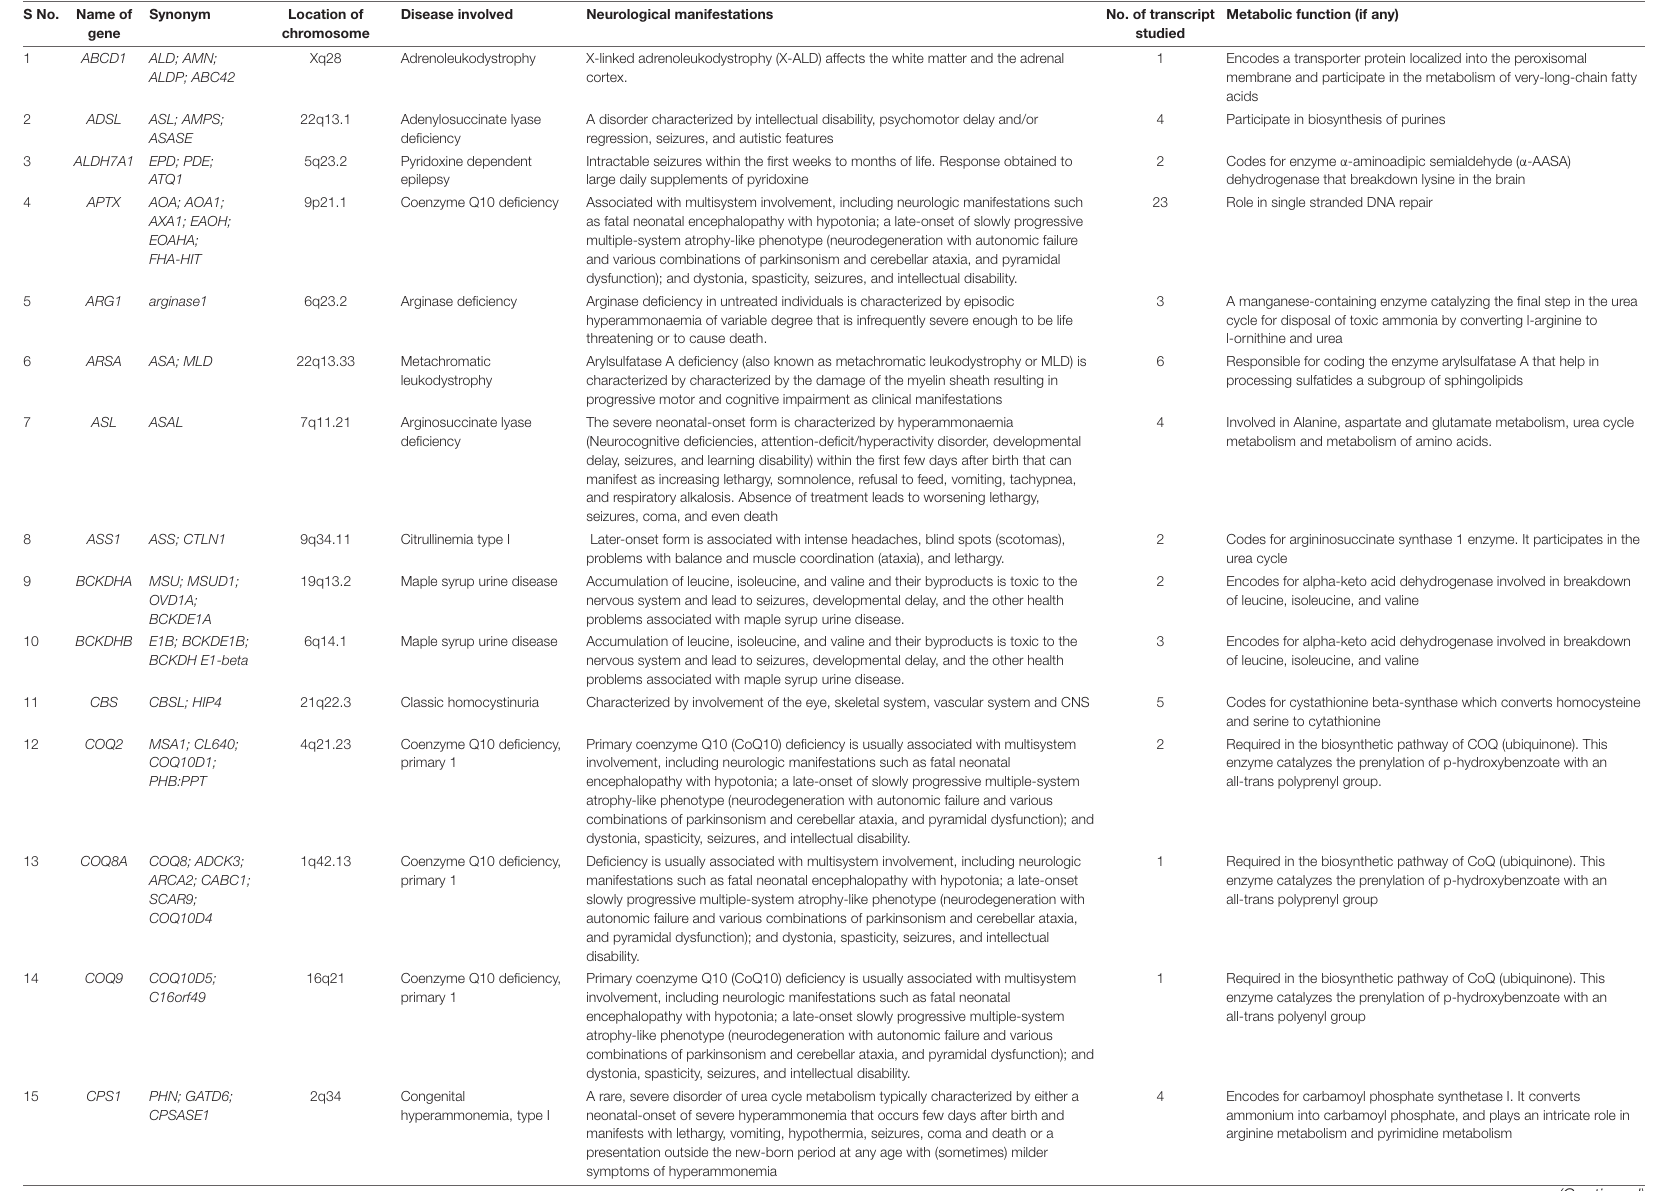
TABLE 1 | The list of genes involved in neurodegenerative disorders with the location on the human chromosome, the disease involved, and the number of transcripts.